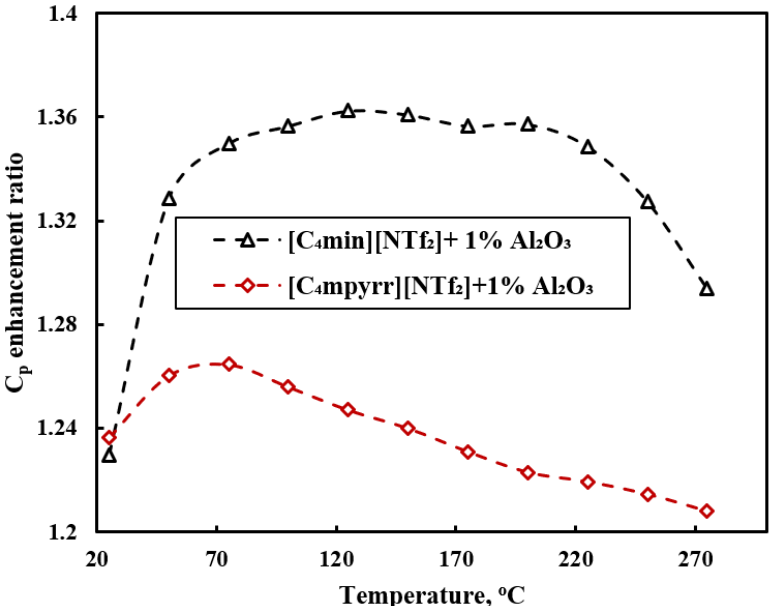
Figure 8. Heat capacity enhancement ratio of NEILs vs. temperature [56]. Reproduced with permission from [Paul], [Procedia Eng.]; published by [Elsevier],